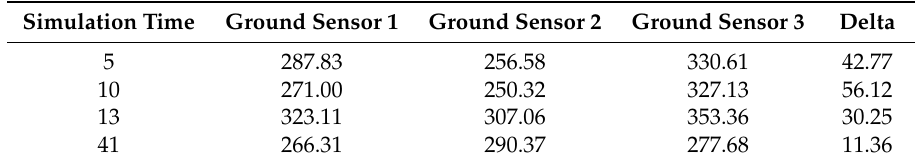
Table 4. Ground sensor values at different simulation times.